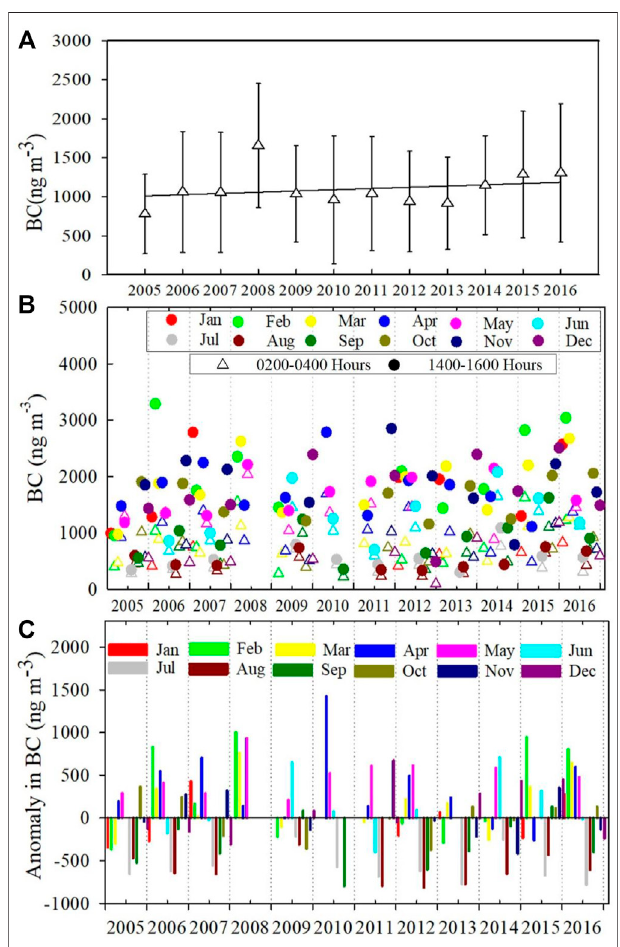
FIGURE 4 | (A) Annual trend in BC during the years 2005 – 2016 along with the standard deviation (±1 σ from the mean). (B) Seasonal variation in the monthly mean night-time (0,200 – 0,400 h) and day-time (1,400 – 1,600 h) BC. (C) Seasonal anomaly in monthly BC calculated for the